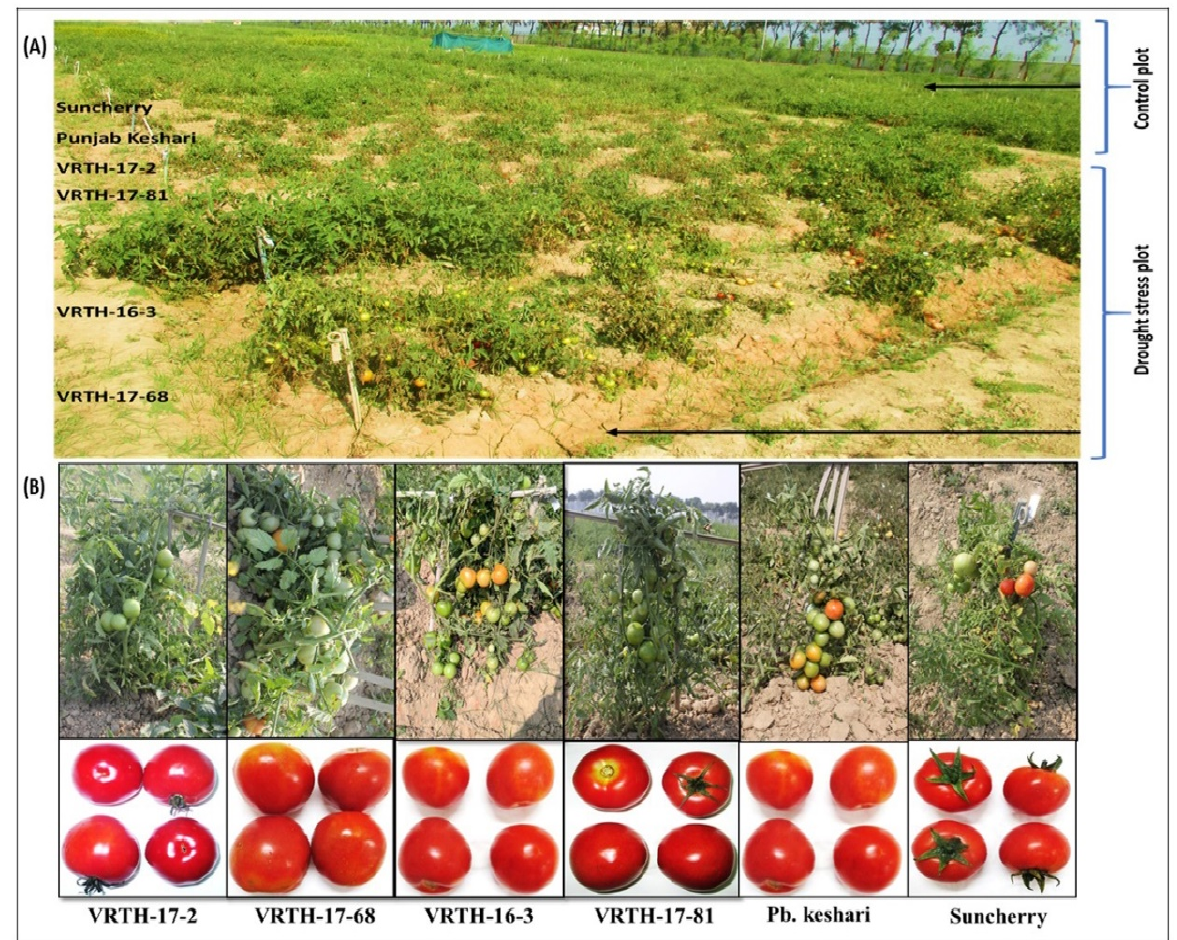
Figure 6. ( A ) Field screening of six genotypes, i.e., four hybrids and two parental lines, as positive controls for drought stress tolerance. All six genotypes were also grown under well water conditions, serving as a control plot. A typical irrigation pattern was followed for both plots until the plants reached their vegetative stage. At the onset of the vegetative stage, the irrigation of the stress plot was stopped. However, the control plot was irrigated regularly. ( B ) The relative performance of all four hybrids and positive controls under drought stress conditions.